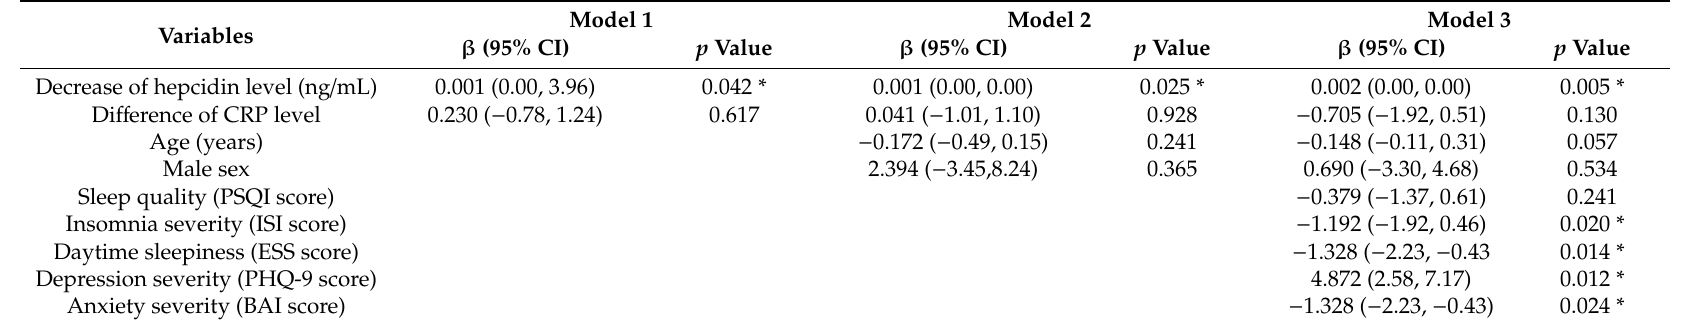
Table 3. Predictors for relief of RLS symptoms three month after treatment ( (cid:52) IRLS